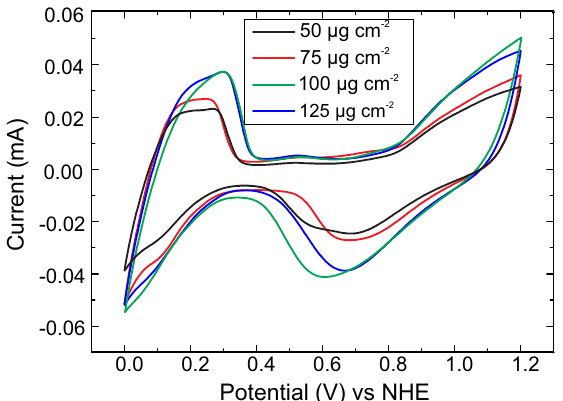
Figure 3. Cyclic voltammograms of PLD samples with various Pt loadings recorded in 0.5 M H 2 SO 4 solution at a scan rate of 20 mV · s − 1